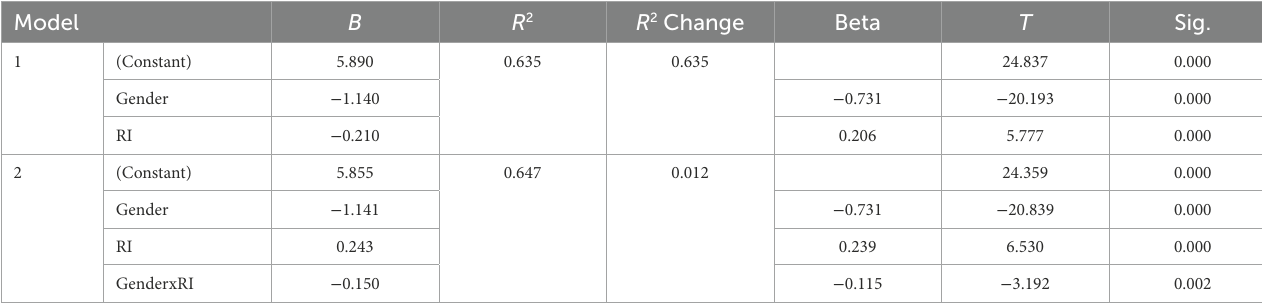
TABLE 5 Effect of gender on the relationship between HR and RI.